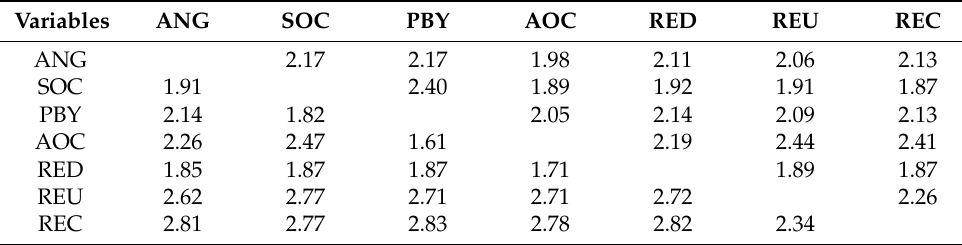
Table 2. Common Method Bias (Collinearity